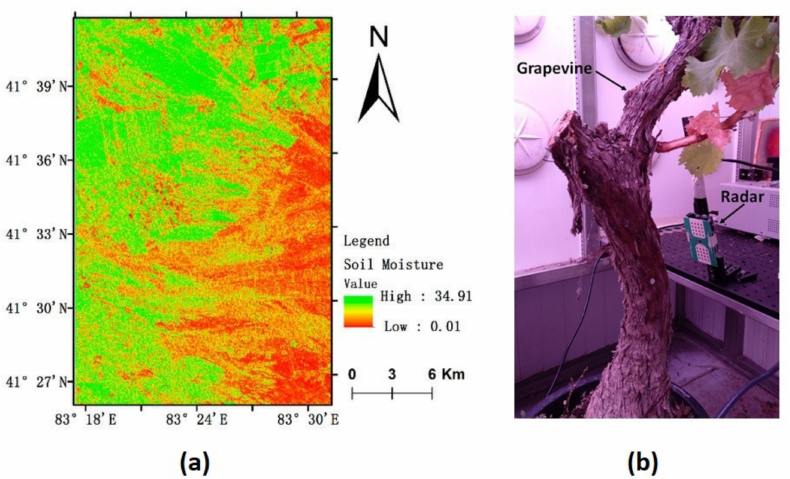
Figure 4. ( a ) Soil moisture content retrieval of the Ugan-Kuqa River Delta Oasis expressed in relative water content (%) by using the Sentinel-1 C-band SAR data [96]; ( b ) Portable FMCW radar from Anteral S.L. applied to a grapevine trunk [84]. Copyright 2021